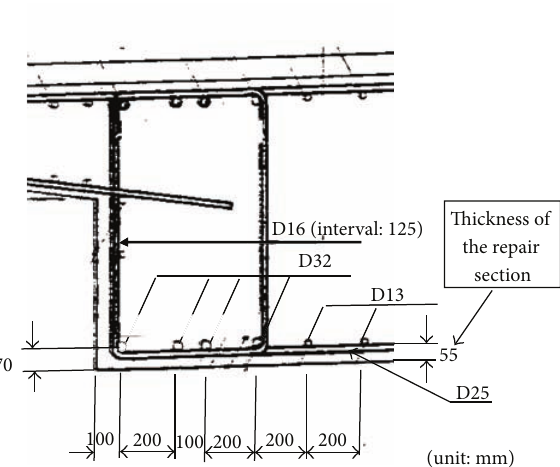
Figure 15: Part of the RC bridge slab.